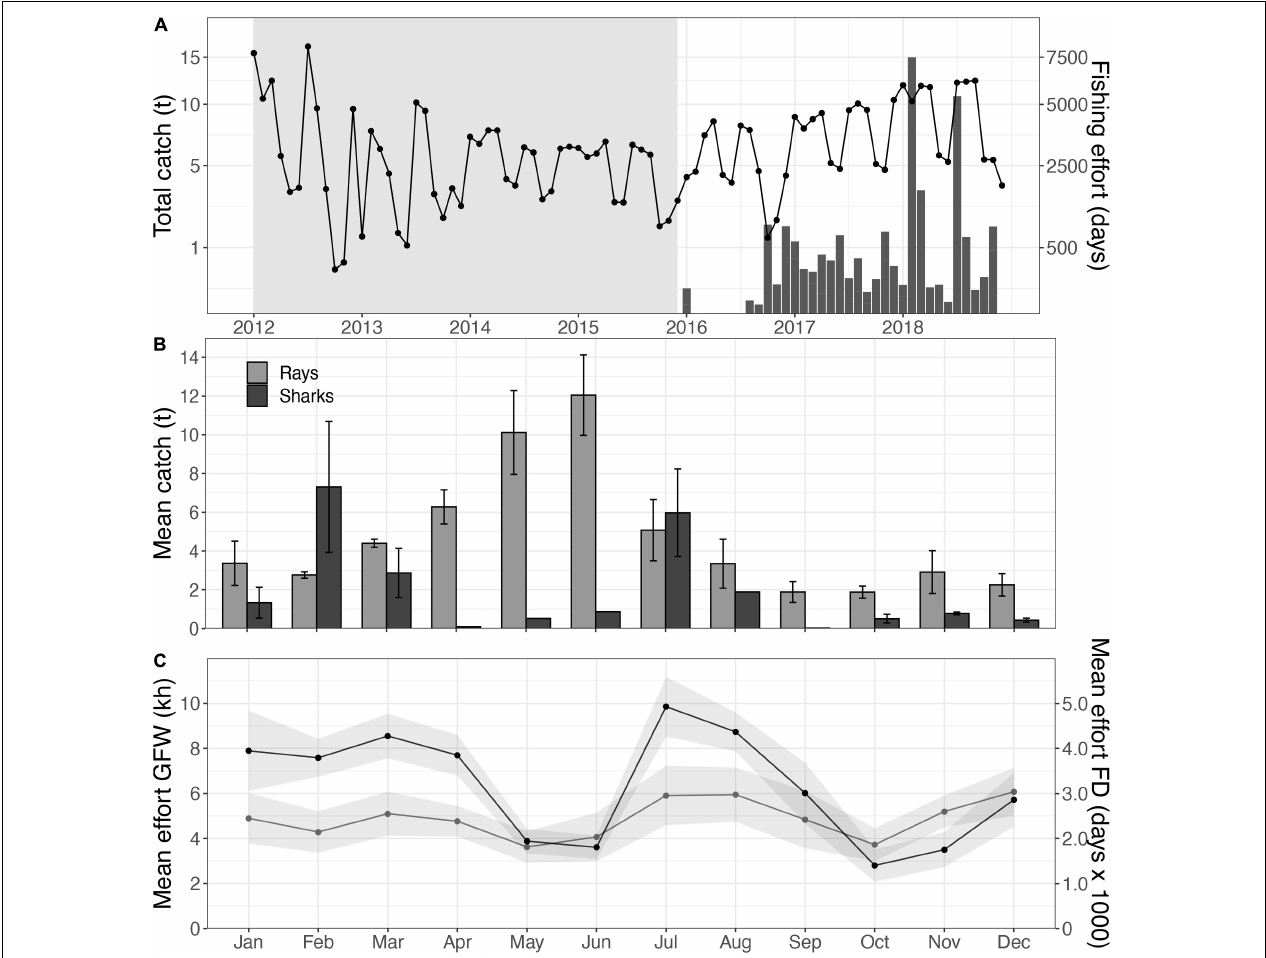
FIGURE 3 | Total elasmobranch catches (bars) and fishing effort (line) within the Mauritanian EEZ, with no-data periods for elasmobranchs indicated in gray (A) ; with a close-up of the monthly mean catches, separated for sharks (black) and rays (gray), over the 2016–2018 period (B) , in relation to fishing effort within the PNBA 2x buffer zone based on the AIS data (gray; in kh), and the total fishing effort in the Mauritanian EEZ as reported by the fisheries institute (black; in fishing days, FD) (C)